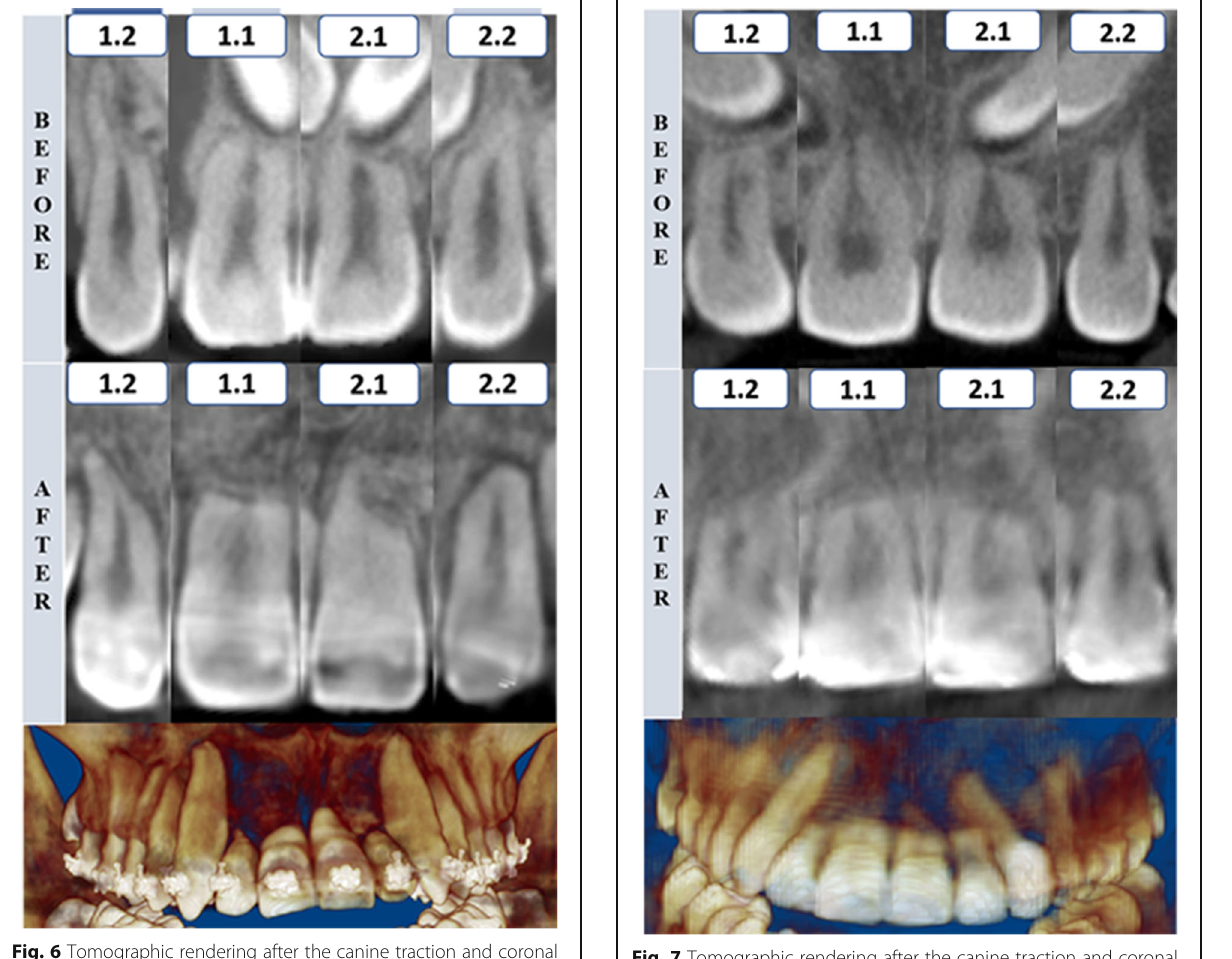
Fig. 7 Tomographic rendering after the canine traction and coronal section of maxillary incisors before and after the impacted canine traction — case 2. 1.2, maxillary right lateral incisor; 1.1, maxillary right central incisor; 2.1, maxillary left central incisor; 2.2, maxillary left lateral